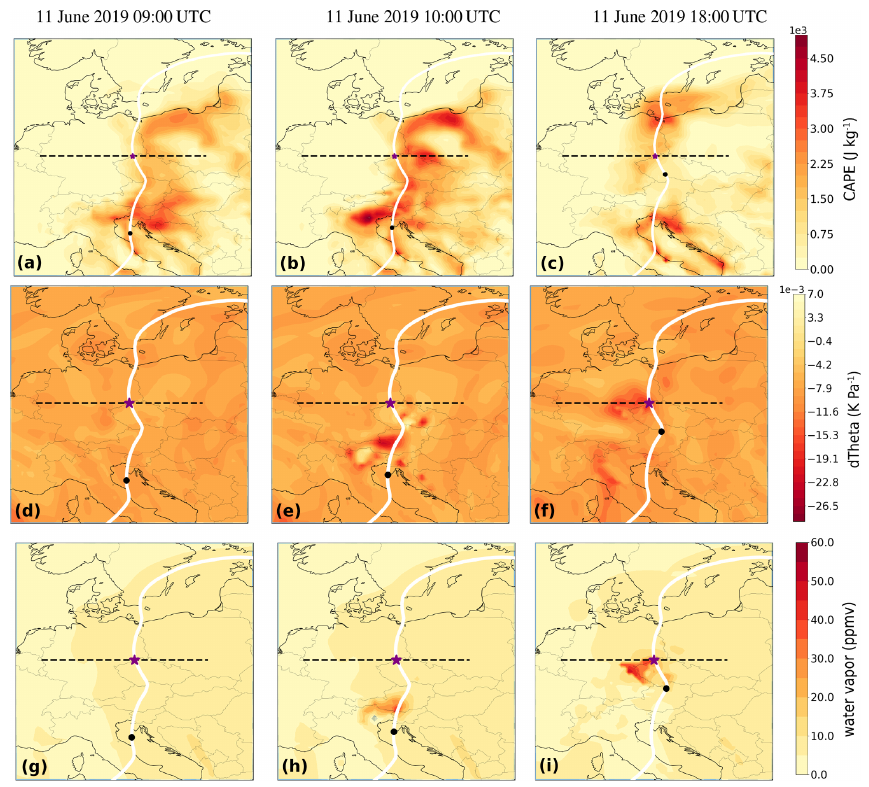
Figure 8. The same as in Fig. 7 but for case 2 with three chosen points in time (09:00, 10:00, and 18:00UTC on 11 June